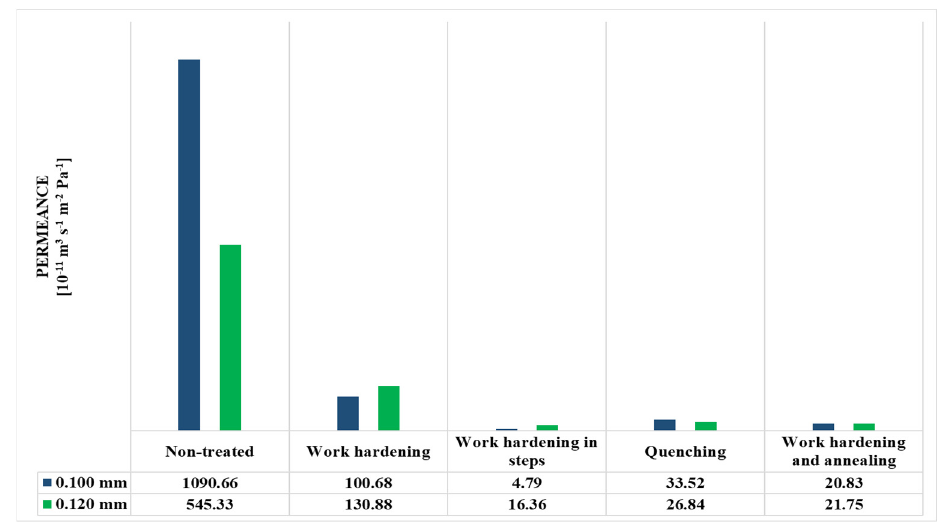
Figure 11. Permeance values (in m 3stp m s − 1 m − 2 Pa − 1 units) of metal membranes.